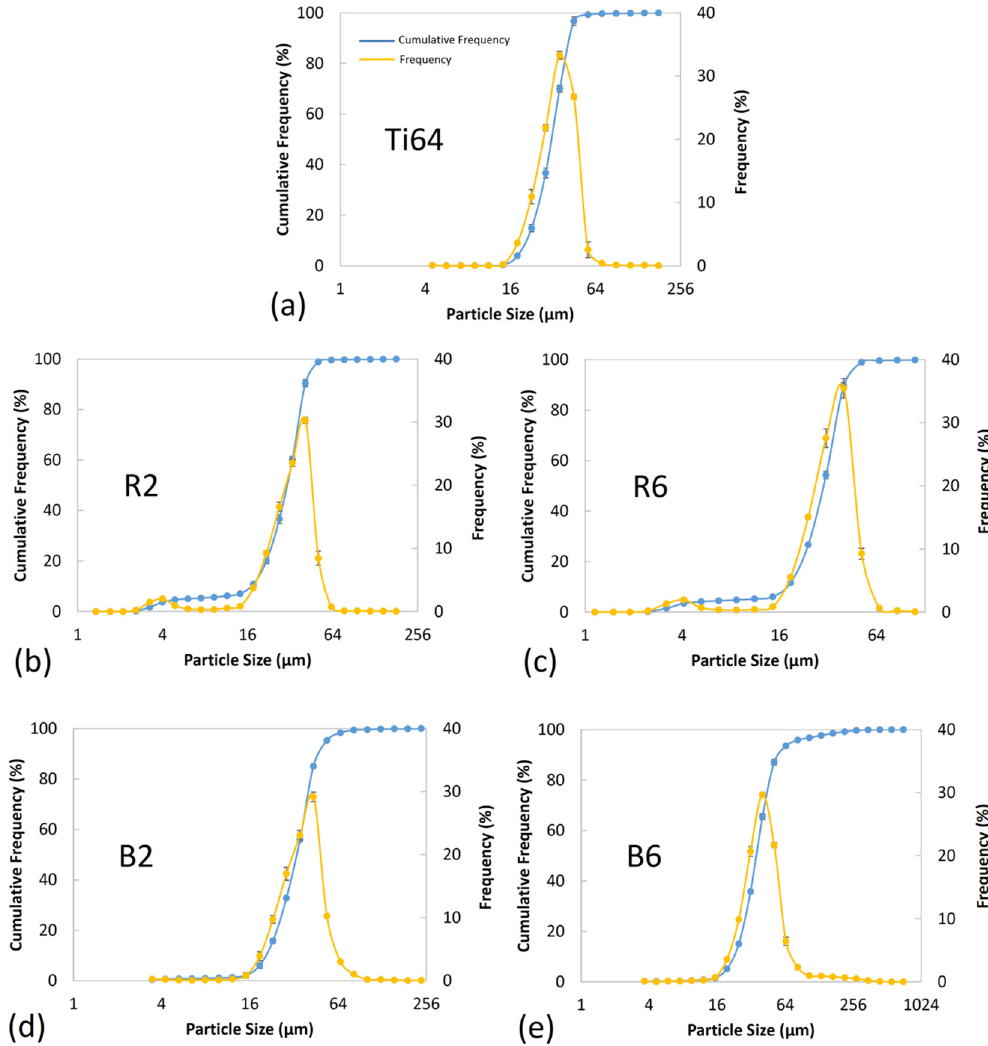
Figure 7. The particle size distribution curves of: ( a ) starting Ti-6Al-4V (Ti64), ( b ) 2 h (R2) and ( c ) 6 h (R6) regularly mixed; ( d ) 2 h (B2) and ( e ) 6 h (B6) ball milled 5wt.% B 4 C/Ti64 composite powder feedstocks. Table 2. The particle size distribution results presenting the cumulative distribution of D10, D50, and D90 for the Ti ‐ 6Al ‐ 4V (Ti64) and the developed composite powders.